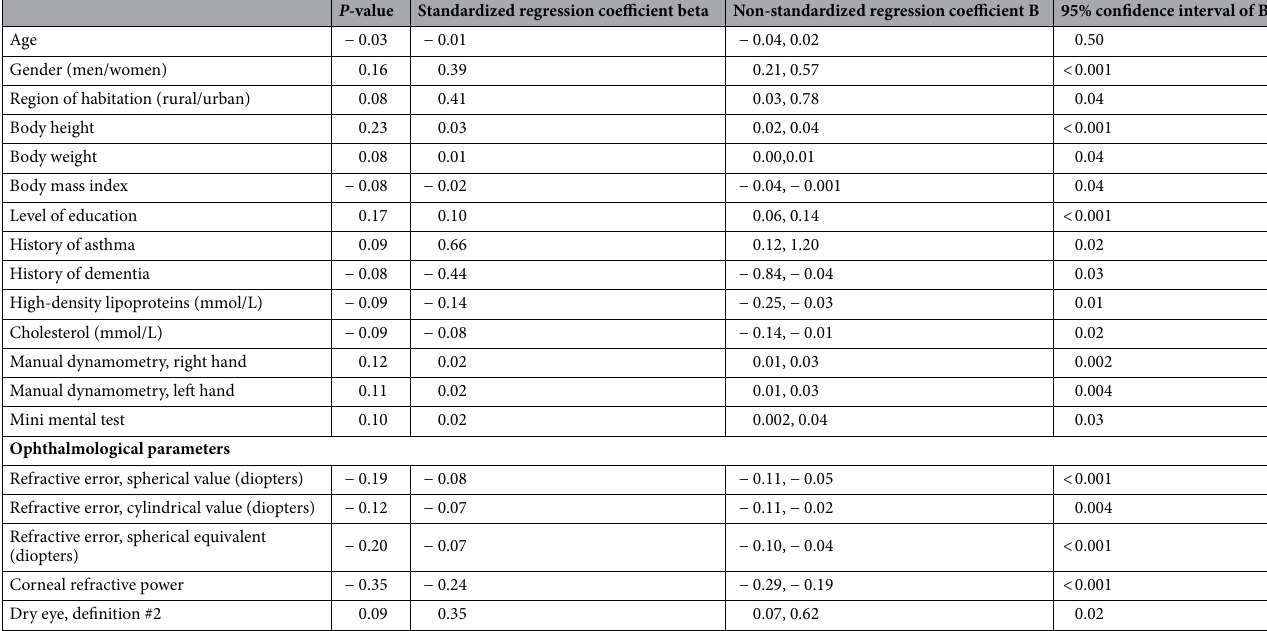
Table 1. Significant associations (univariate analysis) between axial length and systemic parameters in the Ural Eye and Medical